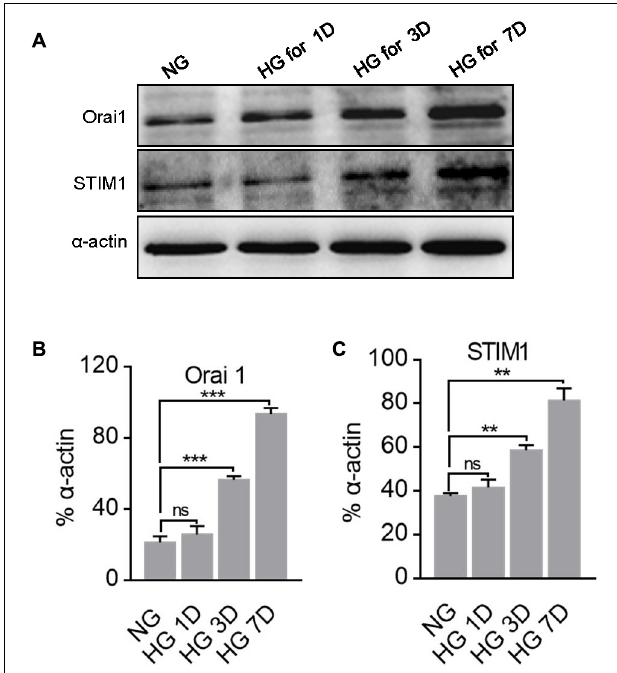
FIGURE 2 | Effect of high glucose (HG) culture medium on Orai1 and STIM1 protein expression in MUS-M1 cells. Representative immunoblotting images (A) and summarized data (B,C) showing the expression levels of Orai1 (B) and STIM1 (C) proteins in MUS-M1 cells cultured in normal glucose (NG,